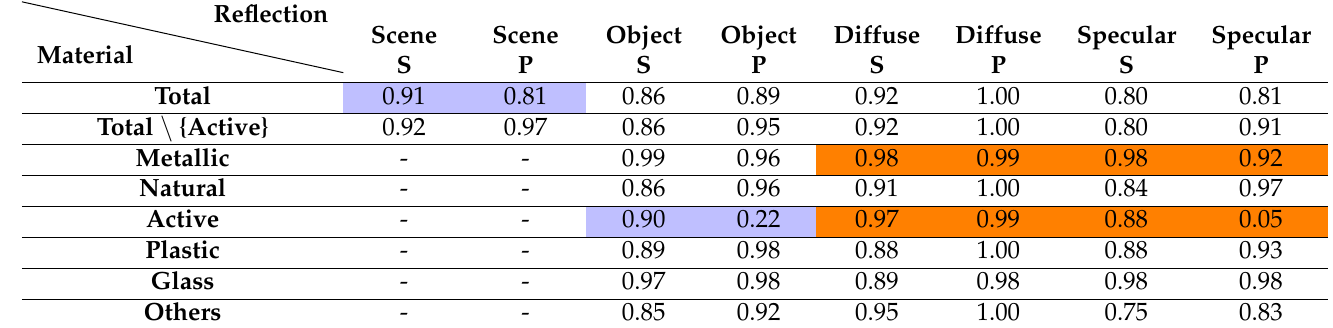
grouping the polarization bands on the one hand, and by grouping the spectral bands on the other hand. An example is shown in Tables 3 and 4, with the correlation results for the scenario Total Object . We provide the 26 data tables and there visualizations in false colors as supplemental material openly available at [41]. Examples of visualization in false colors are shown in Figure 5. Table 2. Means of correlation coefficients for each pair of reflection/material clusters, either in the Spectral (S) or Polarization (P) channels. The coefficients are calculated from the groups shown in Tables 3 and 4. Blue cells indicate the cases where spectral correlation coefficient means are higher than polarization. Cells in orange color have to be taken with care.